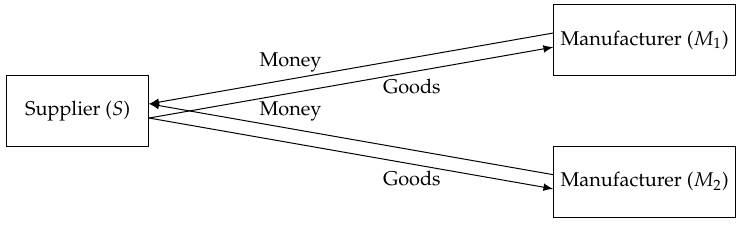
Figure 2. Multi-manufacturer supply